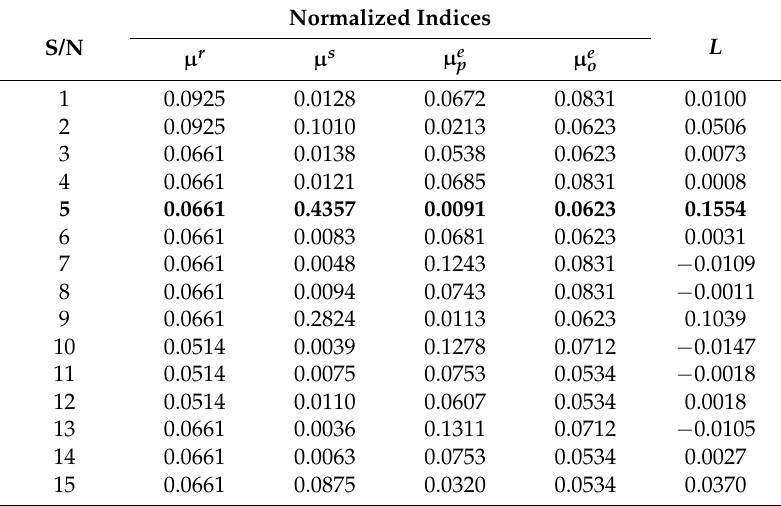
Table 10. Overall indices of the layout